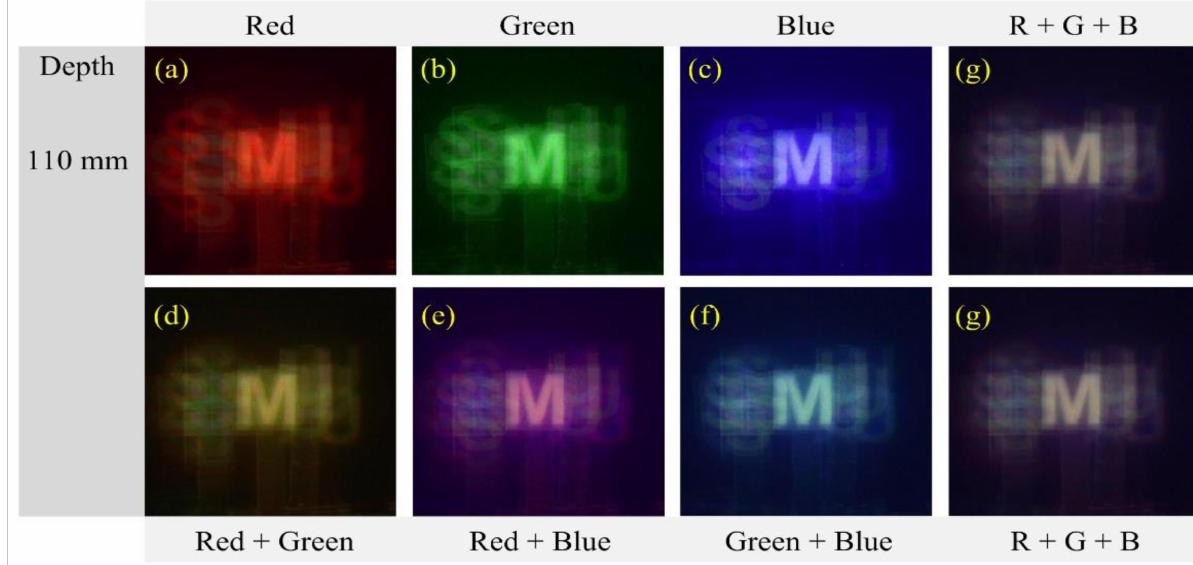
Figure 11. Reconstructed images for the object ‘M’ at a depth z = 110 mm. ( a ) Red ( b ) Green ( c ) Blue ( d ) Red + Green ( e ) Red + Blue ( f ) Green + Blue, and ( g ) Red + Green +